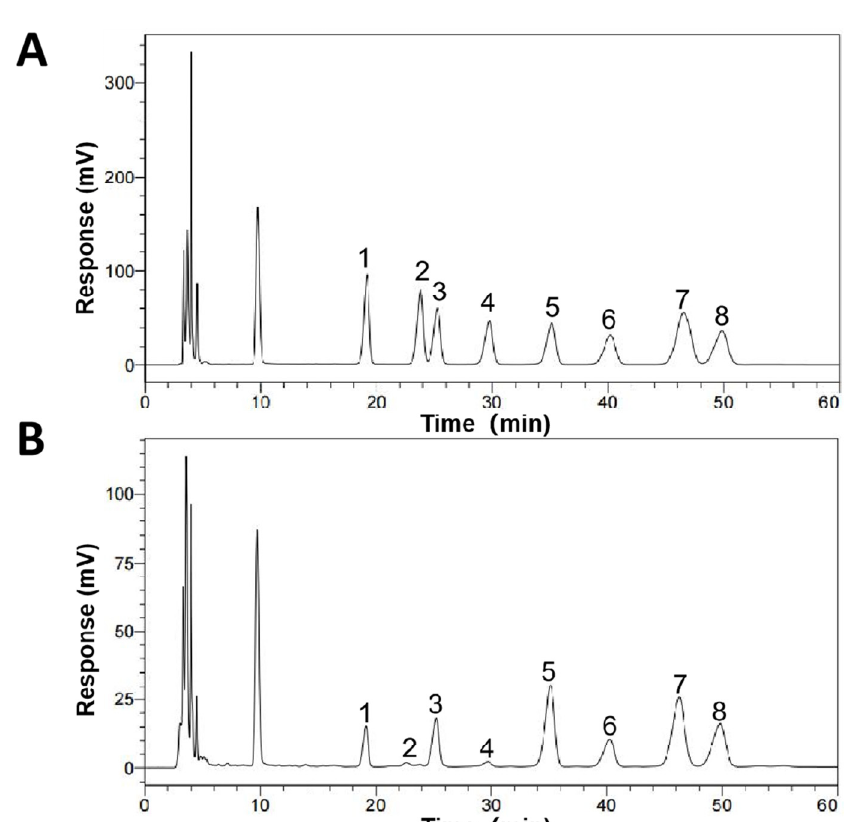
Figure 3. Monosaccharide composition analysis of SCP by HPLC. ( A ) HPLC chromatograms of mixed standards. ( B ) HPLC chromatograms of SCP. Monosaccharide corresponding to each peak: